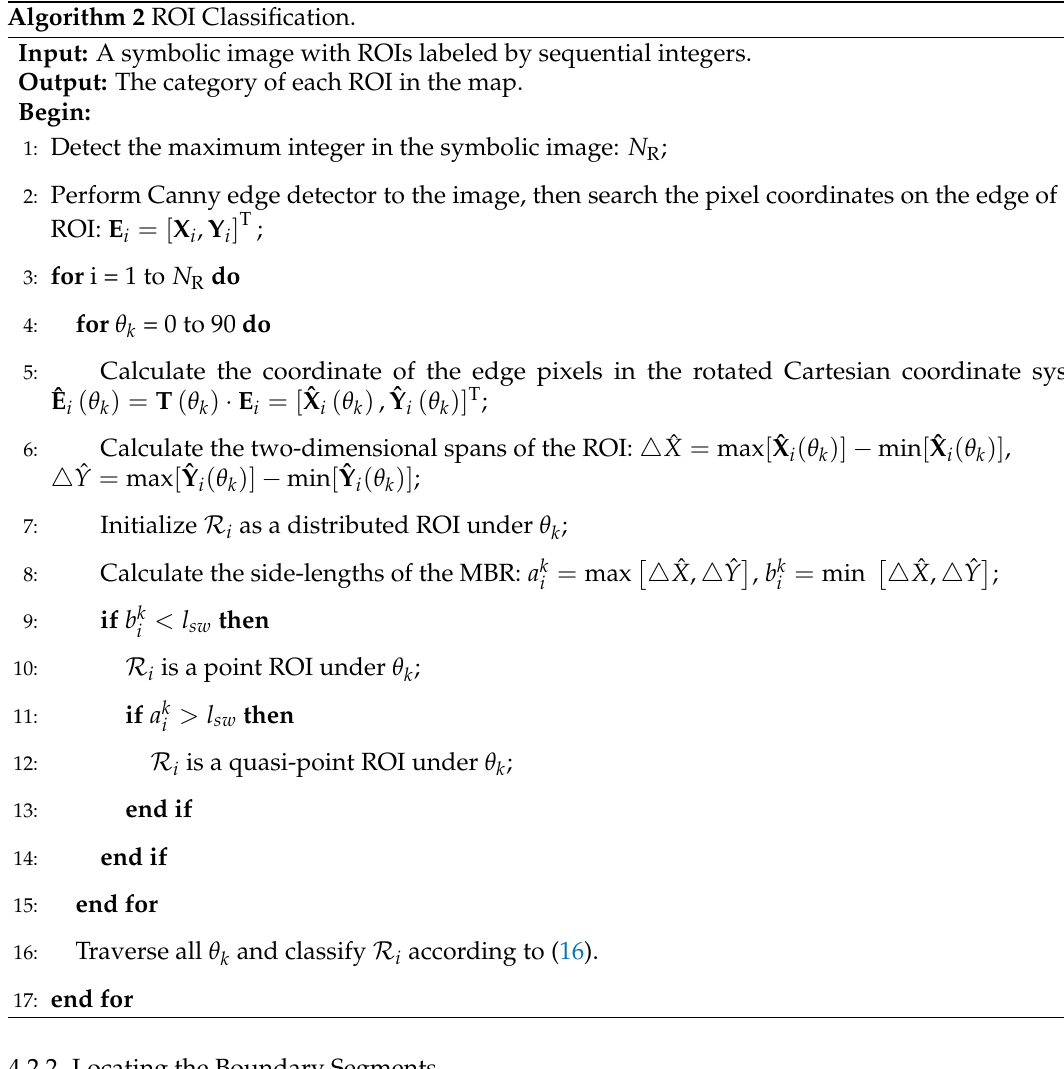
Algorithm 2 ROI